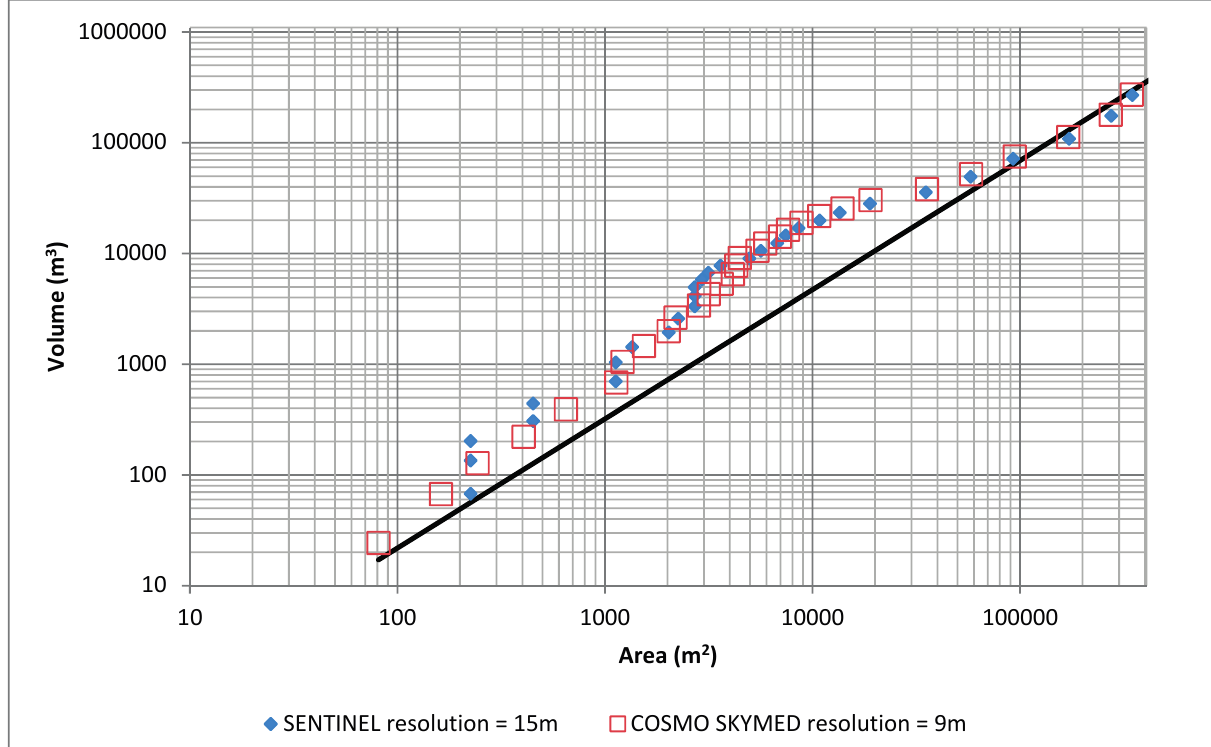
Figure 3. Laaba’s storage volumes as a function of the corresponding surface areas.